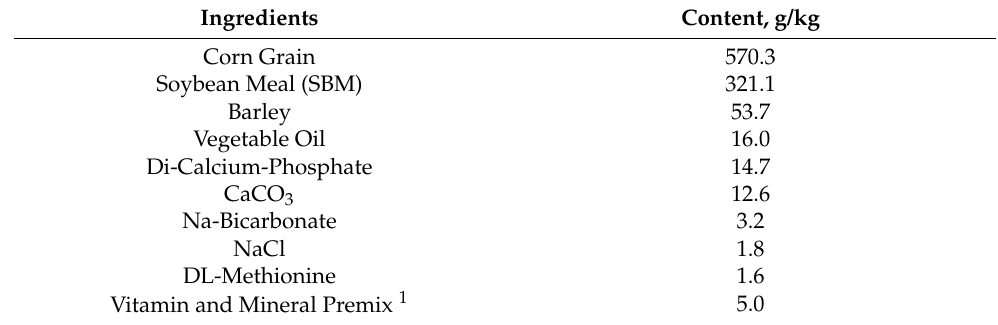
Table 1. Ingredients and nutrient composition of the reference diet (RD) fed to birds from 35 to 42 d of